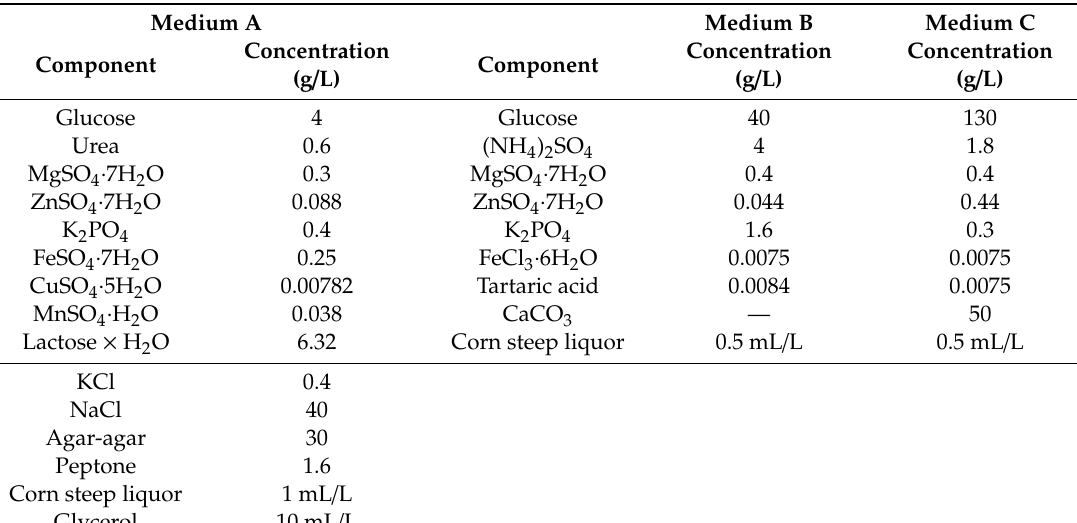
Table 1. Culture media used